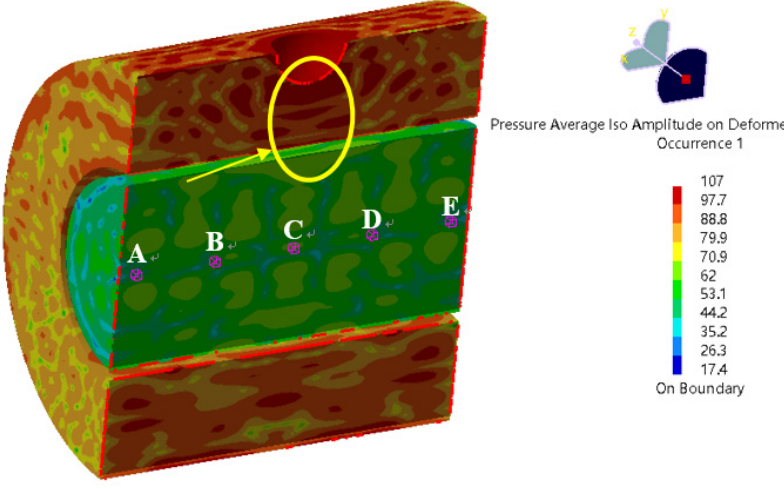
Figure 12. SPL distribution in the annulus region and inside the pipeline (20,000 Hz). The spectrum curves of the sound pressure frequency of five field points (A, B, C, D, and E) on the axis line of the oil pipe are shown in Figure 13. The acoustic wave characteristics are consistent at different positions in the axial direction, and the sound pressure shows no obvious difference. There are several peak values on the frequency spectrum curve of each field point, most of which are concentrated in the range of 25,000–35,000 Hz. At 26,000 Hz, the peak value of the frequency spectrum takes the largest value of 0.309 Pa, i.e., 83.8 dB (the reference value is 2 × 10 − 5 Pa), which is significantly lower than that of the equivalent sound source.